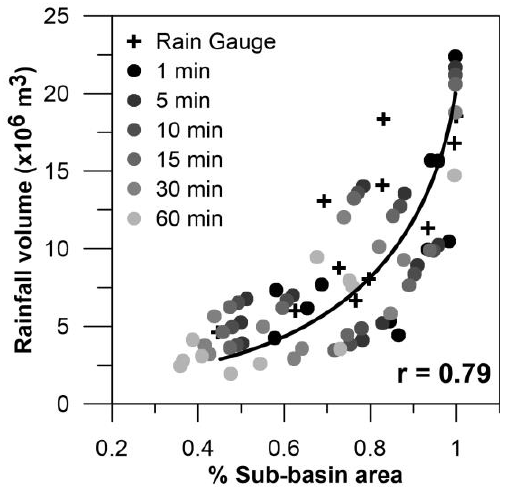
Figure 11. Relation of water volume and its percentage of coverage over the study basin area.